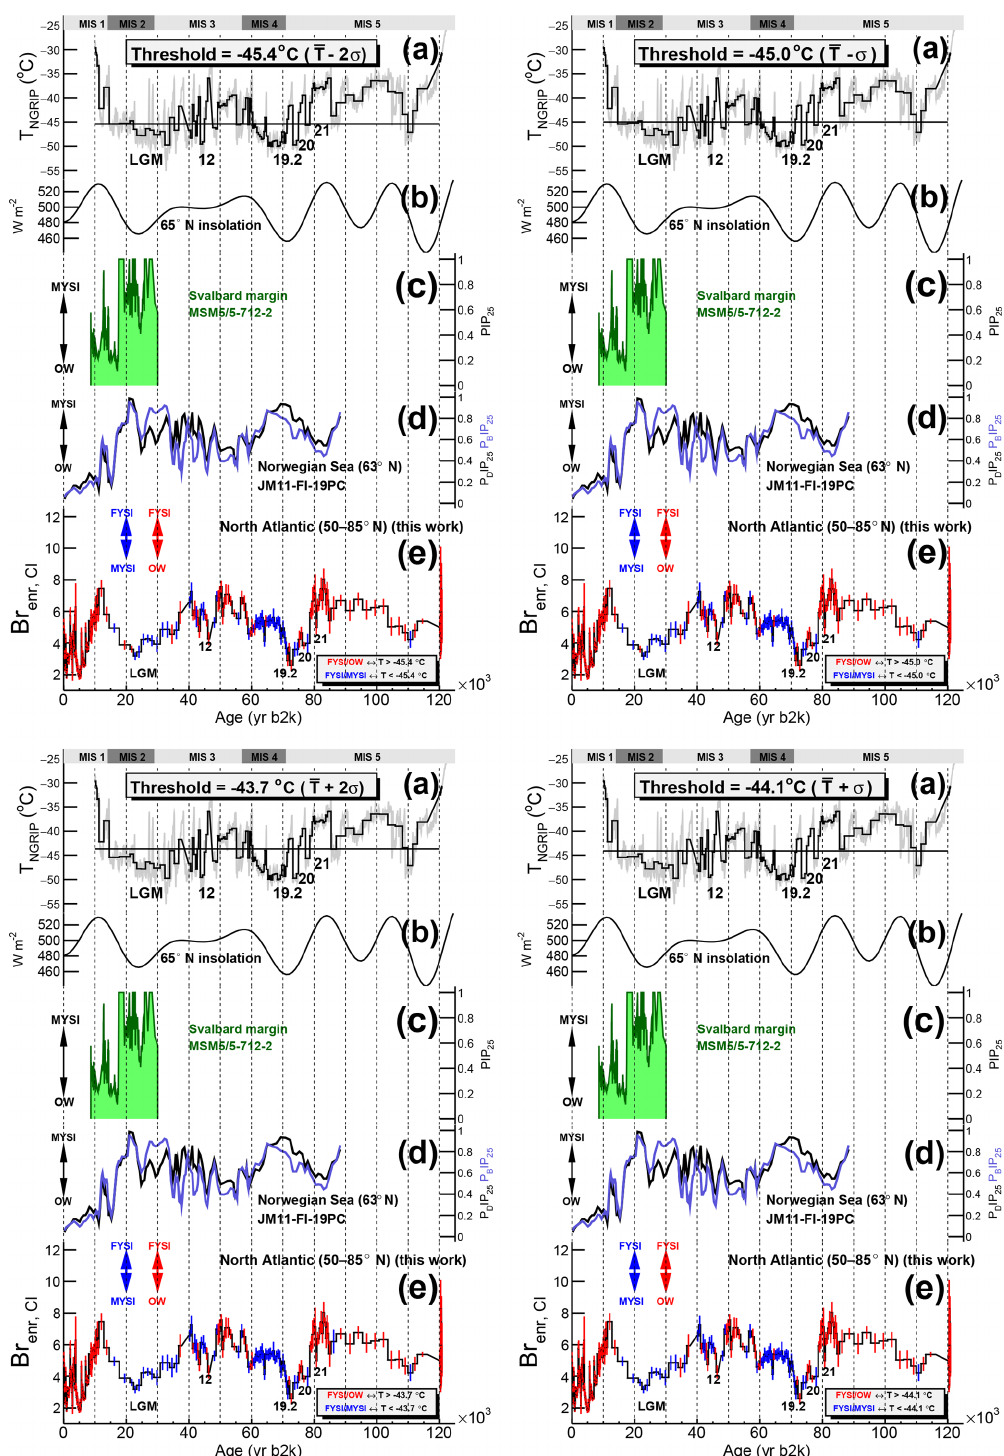
Figure D2. Discrimination between the two Br enr , Cl regimes according to the NGRIP temperature threshold. This figure is equivalent to Fig. D1 with Br enr , Mg replaced by Br enr , Cl